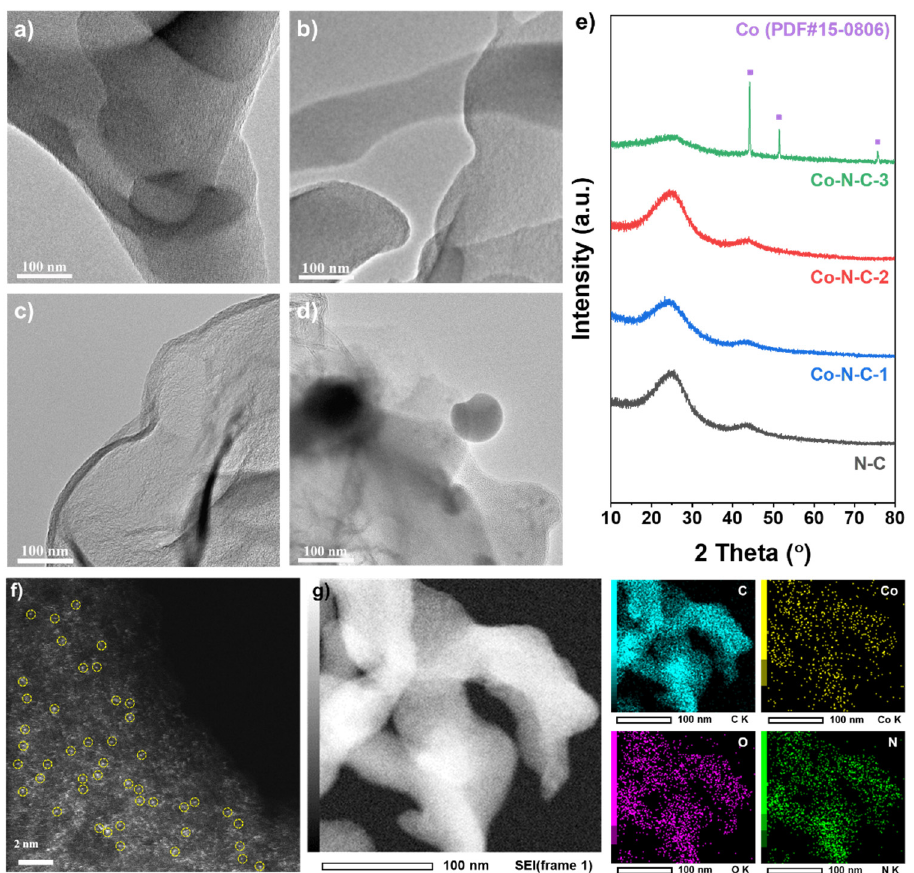
Figure 2. TEM images of ( a ) N-C, ( b ) Co-N-C-1, ( c ) Co-N-C-2, and ( d ) Co-N-C-3; ( e ) XRD patterns of the N-C and Co-N-C catalysts; ( f ) HAADF-STEM image of Co-N-C-2 catalyst (some of the bright dots are marked with yellow circles) and ( g ) the corresponding elemental mapping images.